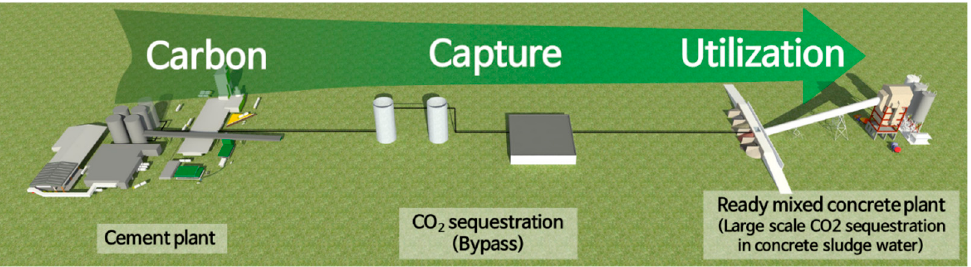
Table 2. Chemical composition of supernatant water (obtained by ICP spectroscopy).